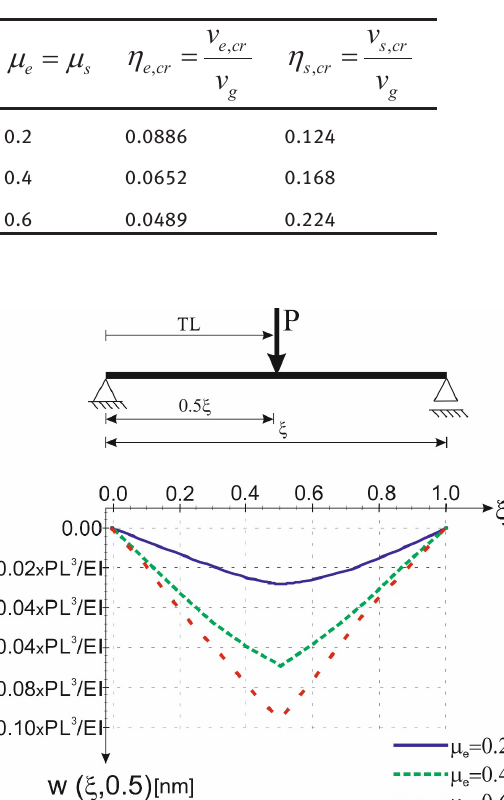
Figure 3: Strain gradient model. Displacement and bending moment of the beam for 0.5 T = , 0.01 g η =